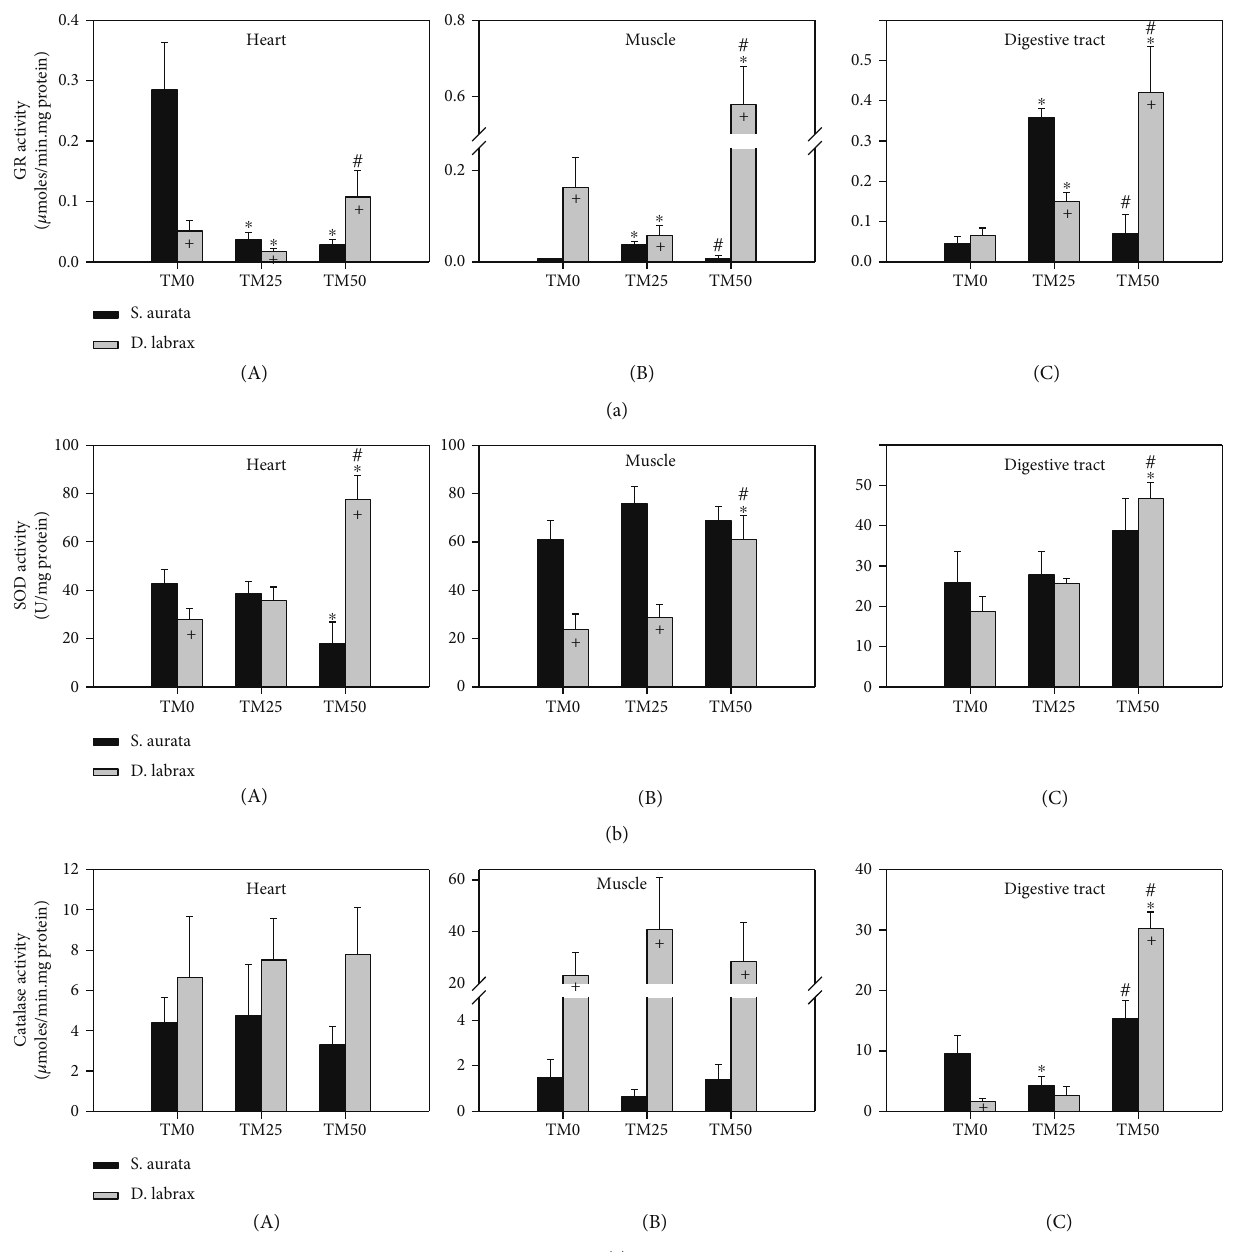
Figure 6: Activities of glutathione reductase (GR) (a), superoxide dismutase (SOD) (b), and catalase (CAT) (c) in the heart (A), muscle (B), and digestive tract (C) of gilthead sea bream ( S. aurata ) and European sea bass ( D. labrax ) under the 0% (TM0), 25% (TM25), and 50% (TM50) T. molitor inclusion diet treatment. Values represent means ± SD ; n = 5 preparations from di ff erent animals. ∗ indicates p < 0 : 05 compared with 0%, # indicates p < 0 : 05 compared with 25%, and + indicates p < 0 : 05 between species at the same TM